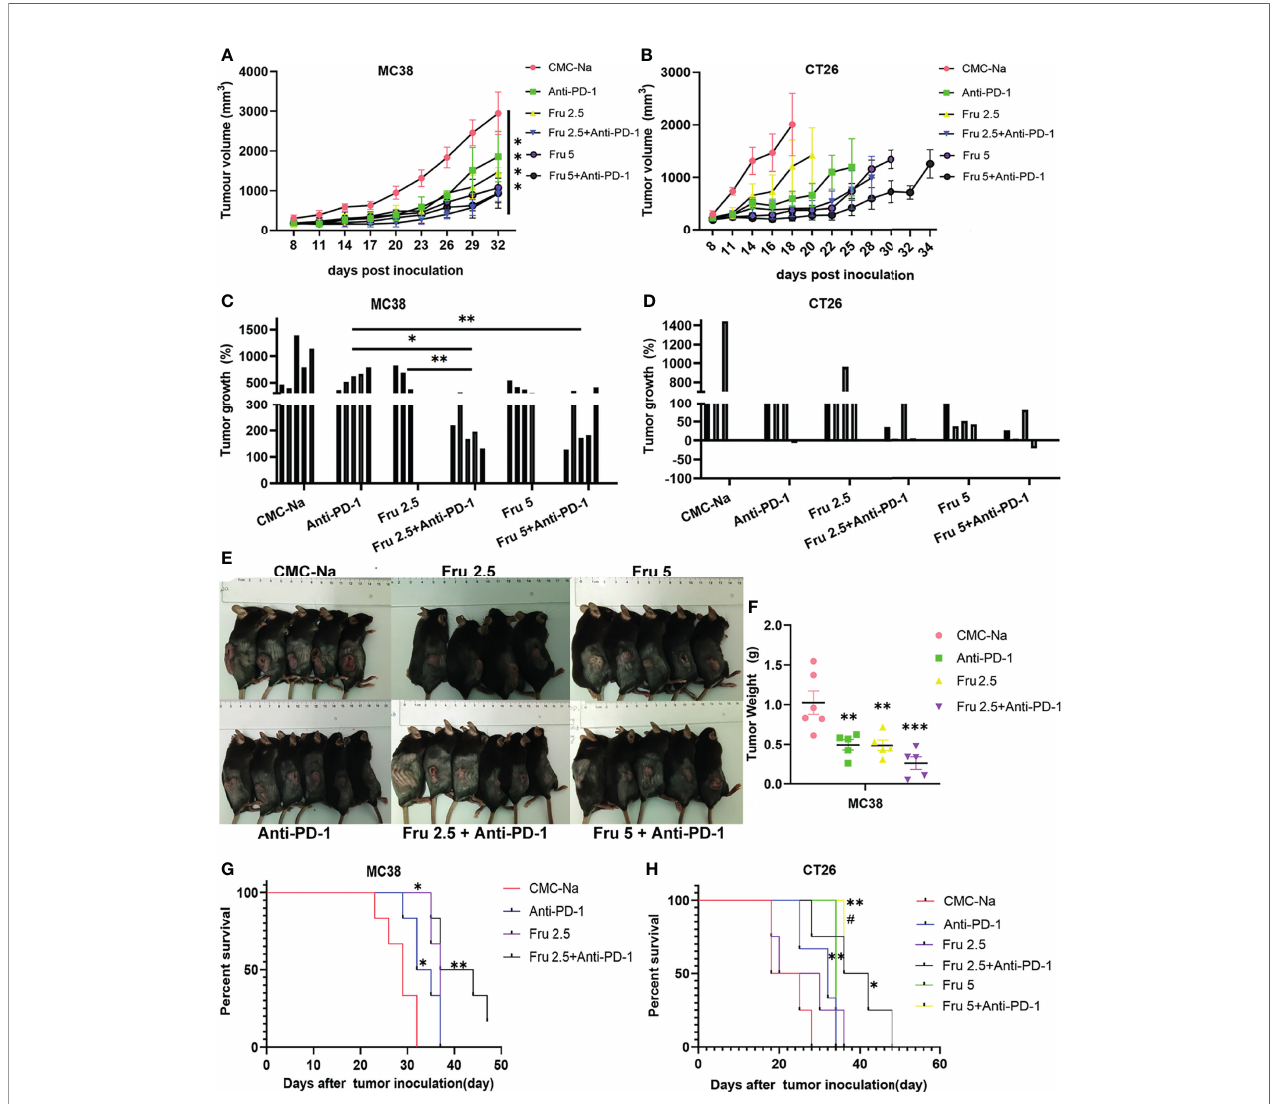
FIGURE 2 | Fruquintinib enhances the anti-tumor effect of anti-PD-1 in CRC mouse models. (A, B) Tumor growth curve of the subcutaneously implanted tumors in MC38 and CT26 mouse models after treatment (n = 4-6). (C, D) Tumor volume of the subcutaneously implanted tumors in each mouse showed in 28 days after treatment (E) Diagram depicting the tumor volume of MC38 allograft tumor model. (F) Tumor weight in the MC38-bearing mice. *p < 0.05, **p < 0.01, ***p < 0.001, ****p < 0.0001 (G, H) Overall survival of MC38 and CT26 tumor-bearing mice. Kaplan-Meier survival curves were shown in each group of implanted tumors #p < 0.05, compared to Fru2.5